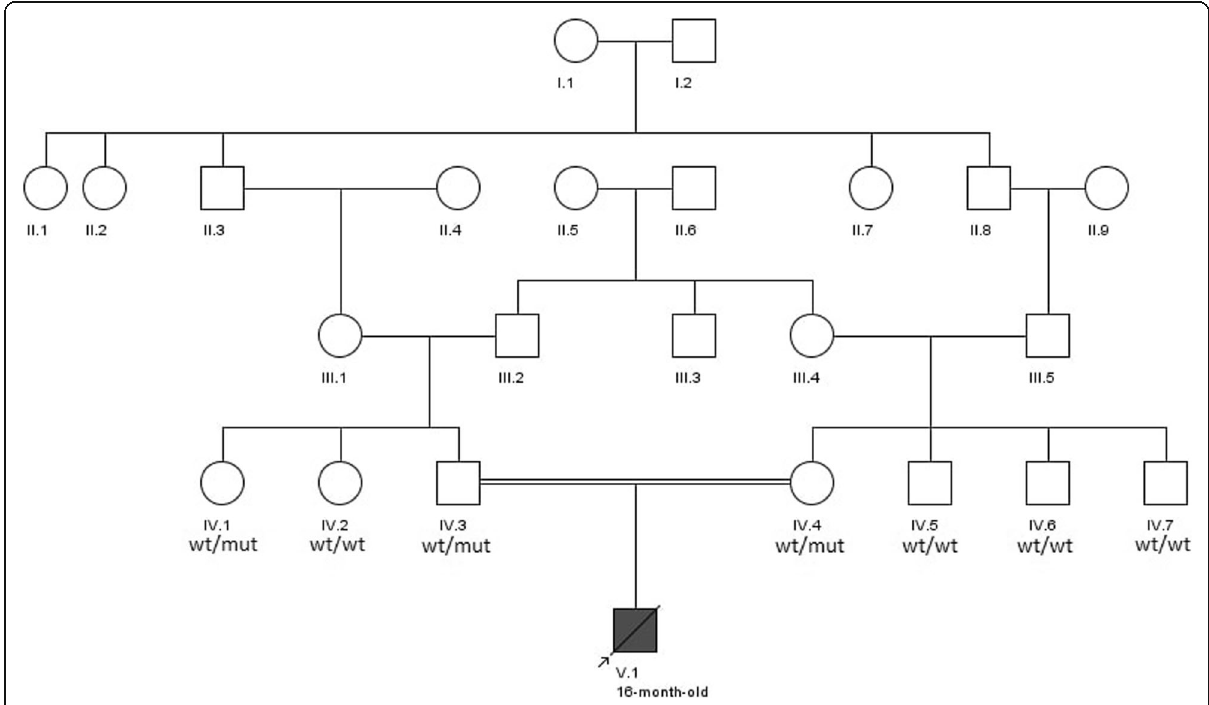
Fig. 1 The family pedigree depicting the mutation in MUT gene. ‘ wt ’ and ‘ mut ’ represent the wild type and pathogenic alleles,